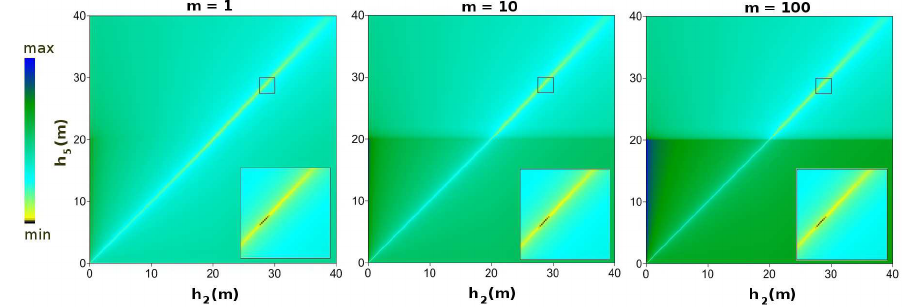
Figure 5. Map of the balance error given by Equation (17), for the approach of Doherty [3], as a function of the hydraulic heads h ( 2 ) ( x axis) and h ( 5 ) ( y axis), for different values of m (( left ) m = 1; ( center ) m = 10; ( right ) m = 100). At the bottom right corner of each graph, the zone containing the minimum error value is